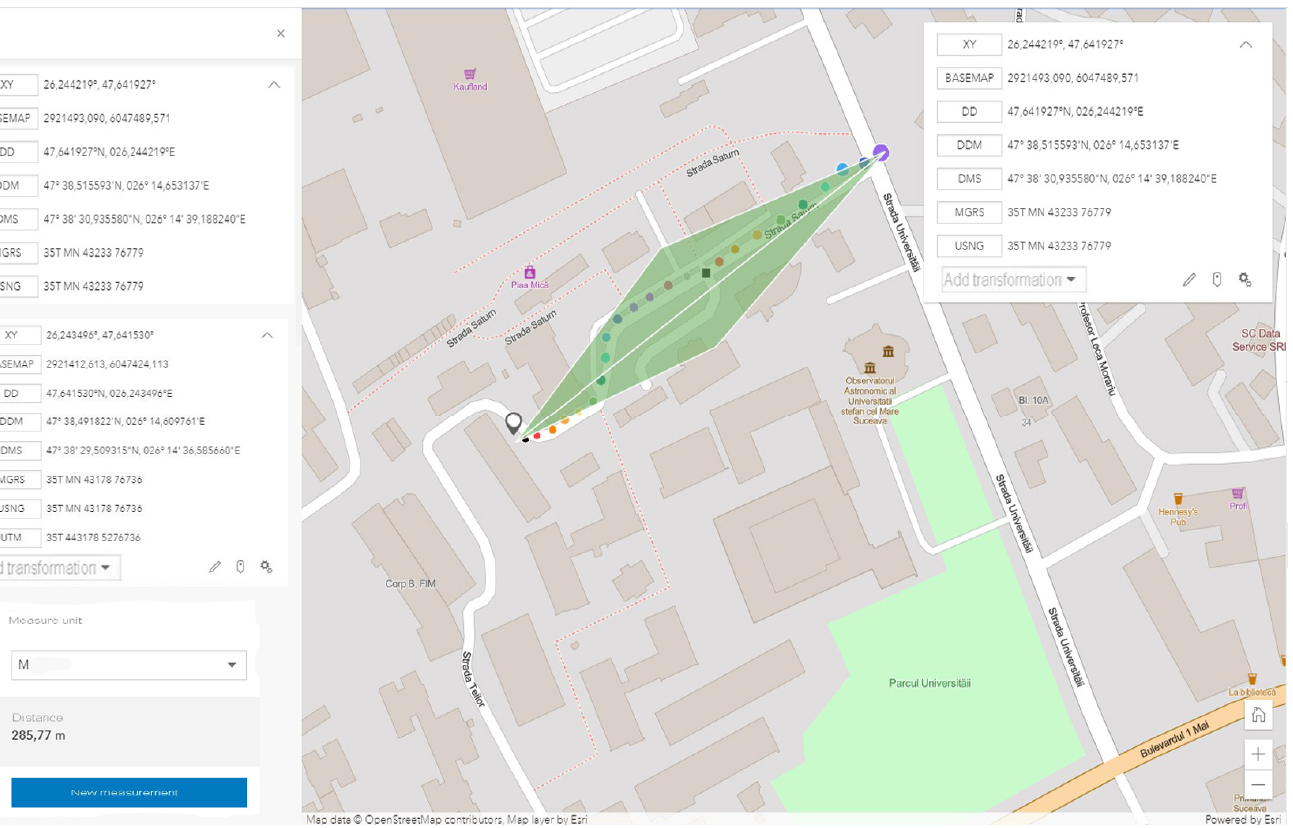
Figure 23. Controllable perimeter scenarios and covered